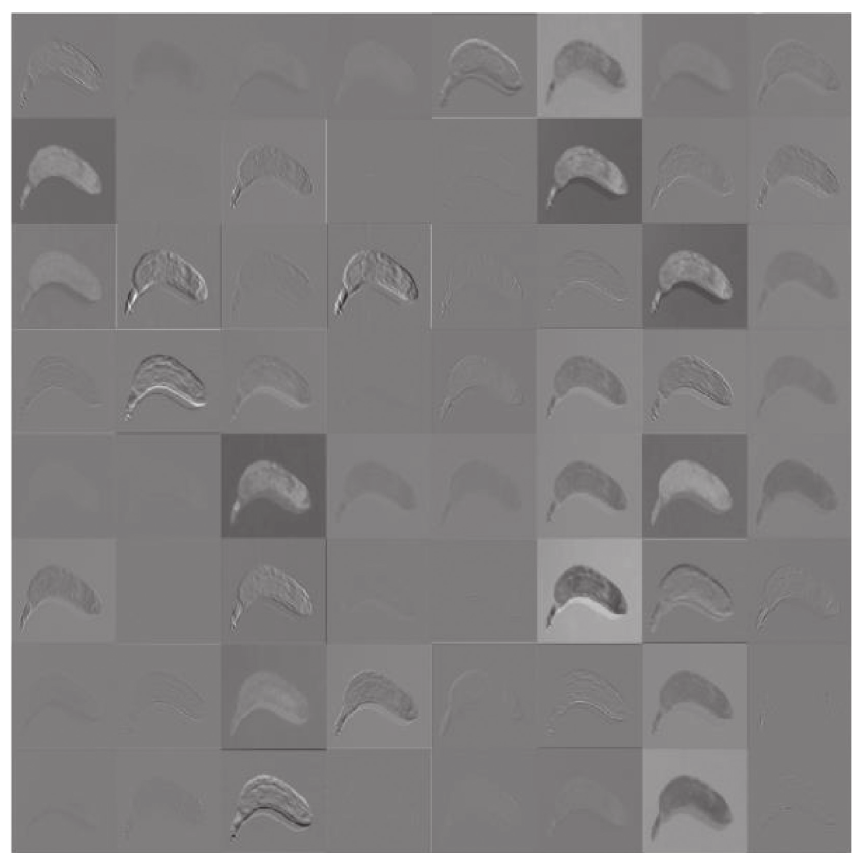
Figure 8: Learned features of the convolution layer